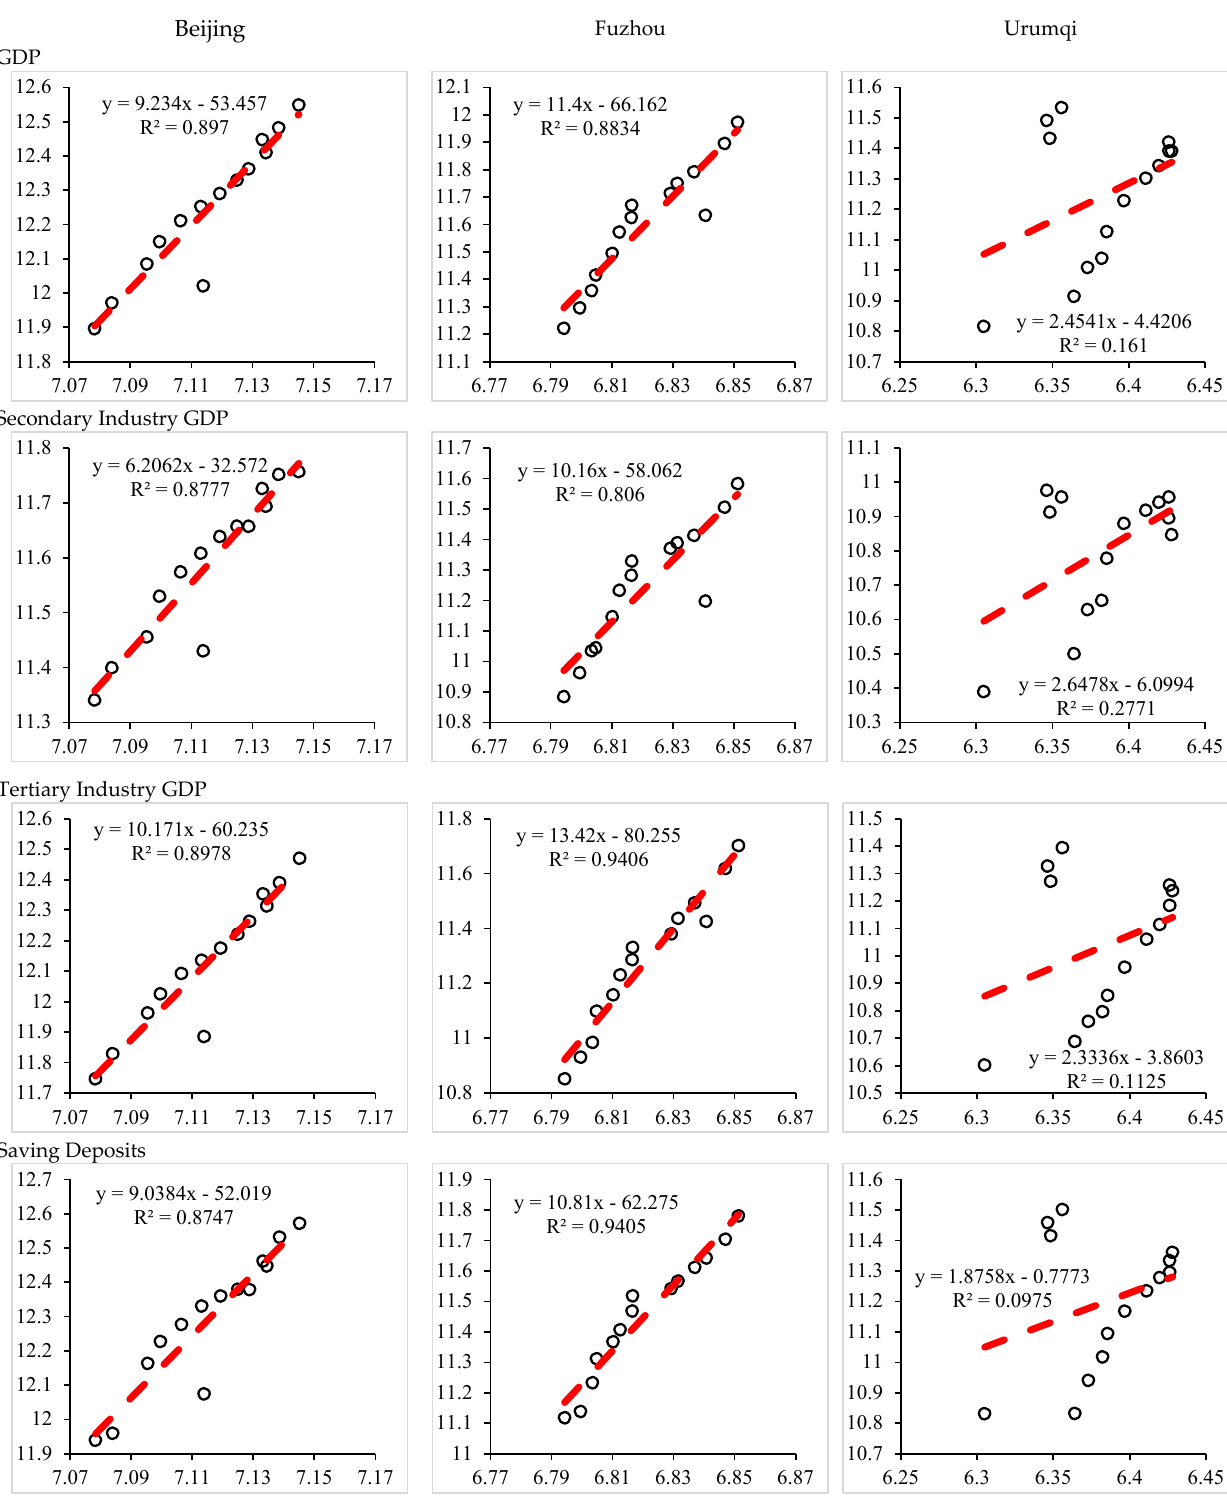
Figure A1 . Urban scaling law fitting results of urban resilience indicators in 2019.